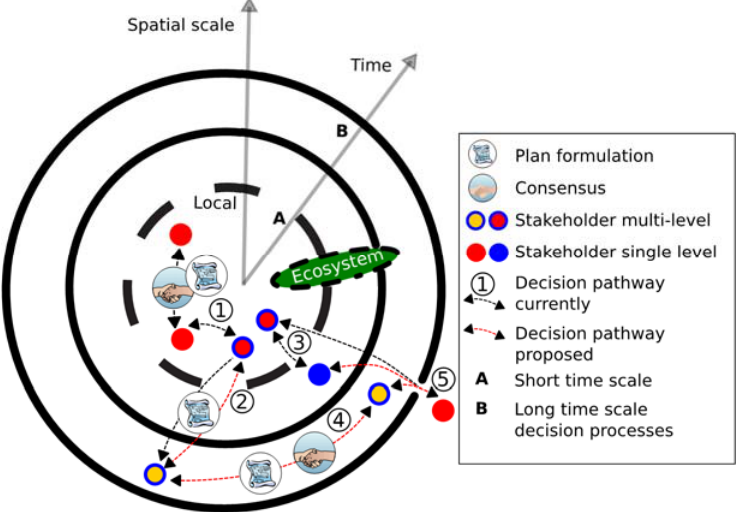
Figure 9. A conceptualisation of decision-making across spatio-temporal scales that follows five different decision pathways to implement adaptive ecosystem management. Agenda setting, plan formulation and implementation take place across both jurisdictional and ecosystem scales, and decisions pathways are either short ‐ term (zone A) or long ‐ term (zone B).